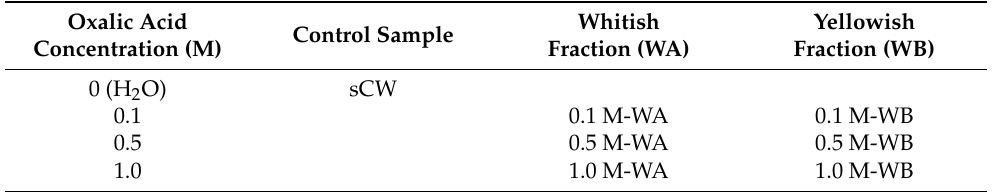
Table 1. Identification of the as-synthesized